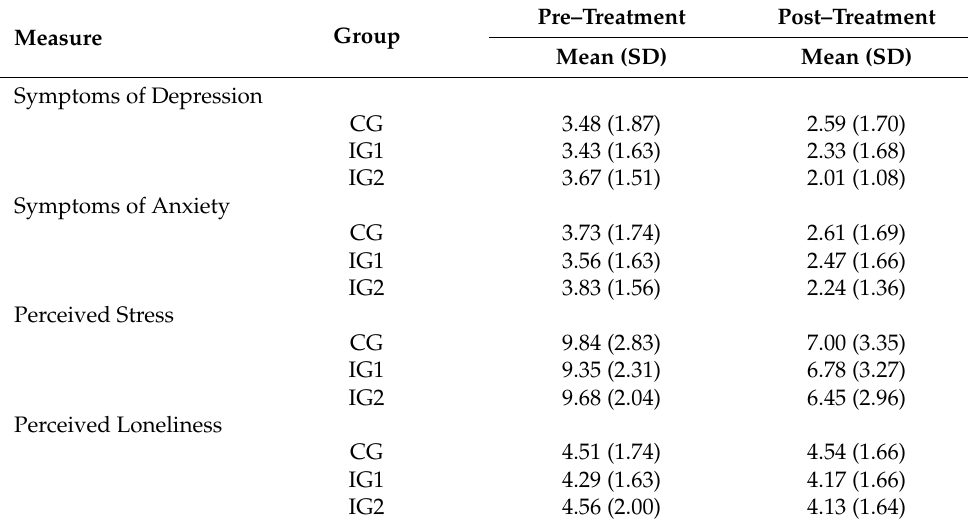
Table 1. Descriptive statistics (estimated marginal means (M), and standard deviations (SD)) for treatment outcomes for all treatment groups from pre–rehabilitation to post–rehabilitation ( n =